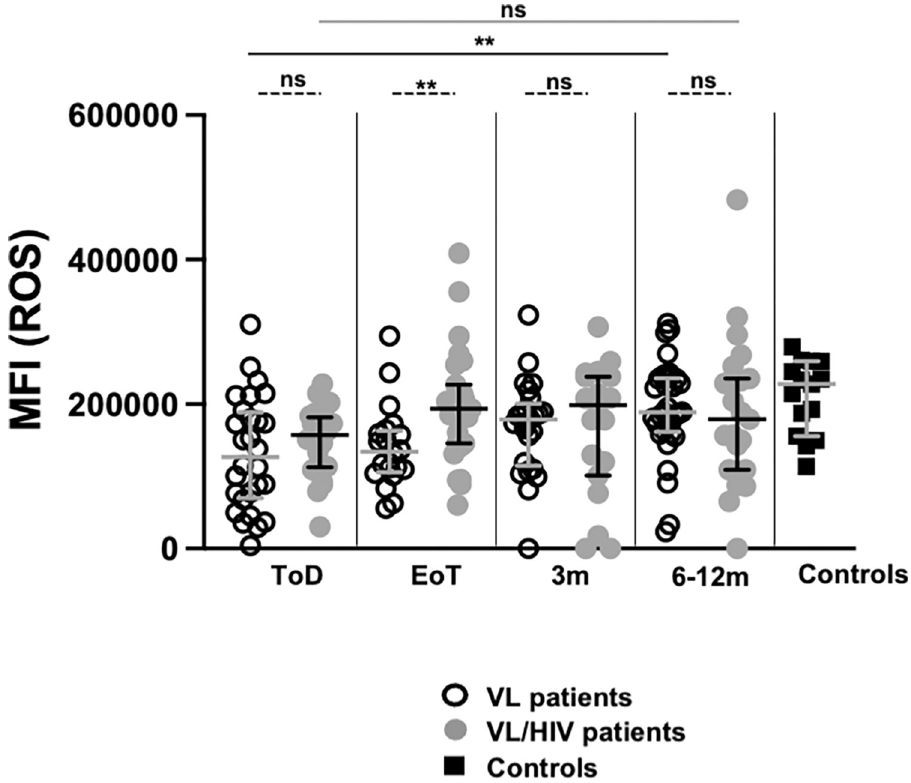
Fig 4. Comparison of ROS production by neutrophils between VL and VL/HIV patients and controls over time. Neutrophils were isolated by dextran sedimentation from the blood of controls (n = 15), VL (ToD: n = 28, EoT: n = 20, 3m: n = 25, 6-12m: n = 33) and VL/HIV (ToD: n = 22, EoT: n = 27, 3m: n = 19, 6-12m: n = 23) patients and incubated in the presence or absence of pyocyanin. The production of ROS was evaluated by subtracting the MFI obtained from the neutrophils incubated without pyocyanin (baseline) from those incubated in the presence of pyocyanin, as measured by flow cytometry. Each symbol represents the value for one individual. Results are presented as median with interquartile range. Statistical differences between VL and VL/HIV patients at each time point were determined using a Mann-Whitney test and statistical differences between the 4 different time points for each cohort of patients were determined by Kruskal-Wallis test. ToD = Time of Diagnosis; EoT = End of Treatment; 3m = 3 months post EoT; 6-12m = 6–12 months post EoT. ns = not significant.